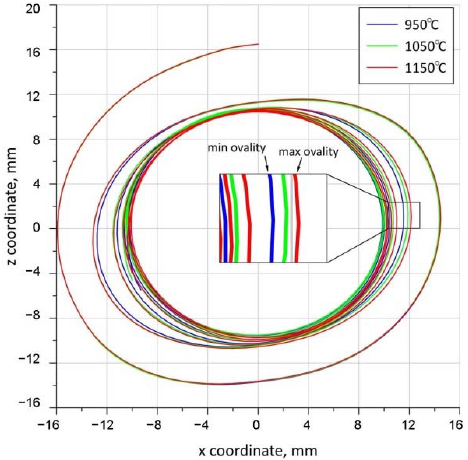
Figure 12. Trajectories of movement of point P1 at different rolling temperatures.